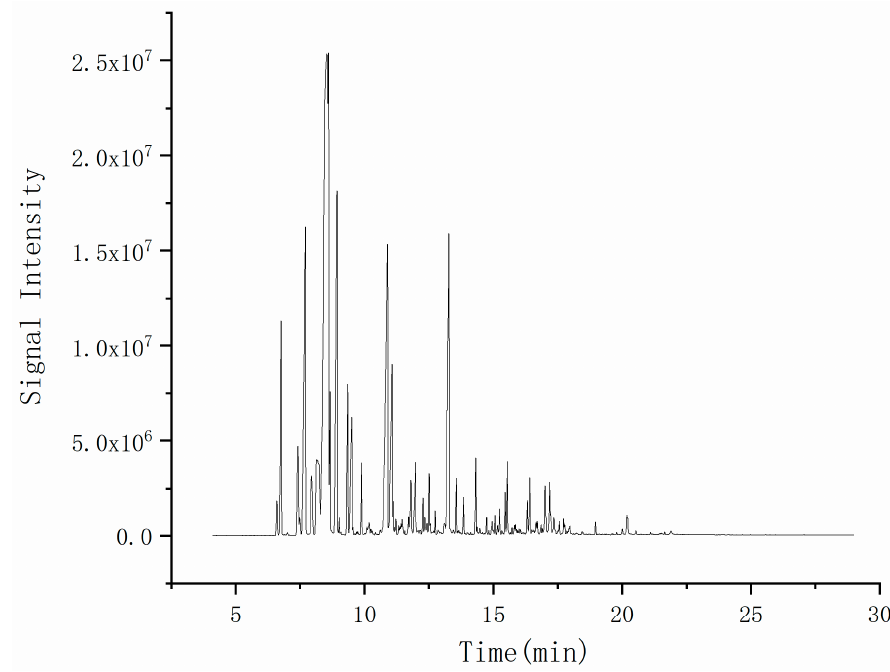
Figure 2. Total ion flow diagram of Zanthoxylum bungeanum essential oil.